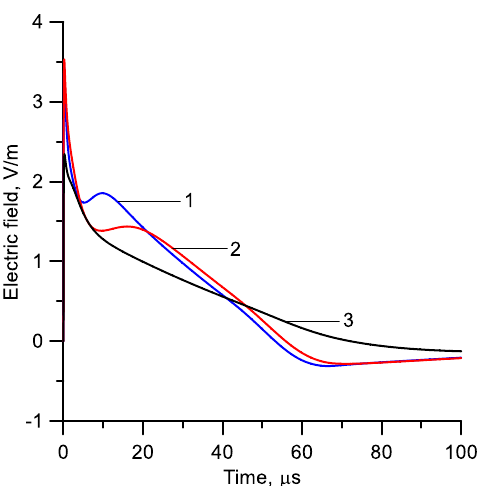
Figure 7. Radiation field at 100 km for different forms of the dispersion function. (1) t r ( z ) = 2.5 × 10 − 6 [ 1 − e − ( z /500 ) 2 ] , (2) t r ( z ) = 5.0 × 10 − 6 [ 1 − e − ( z /1000 ) 2 ] , (3) t r ( z ) = 5.0 × 10 − 6 z /1000.0. In these equations, z is the height along the return stroke channel.